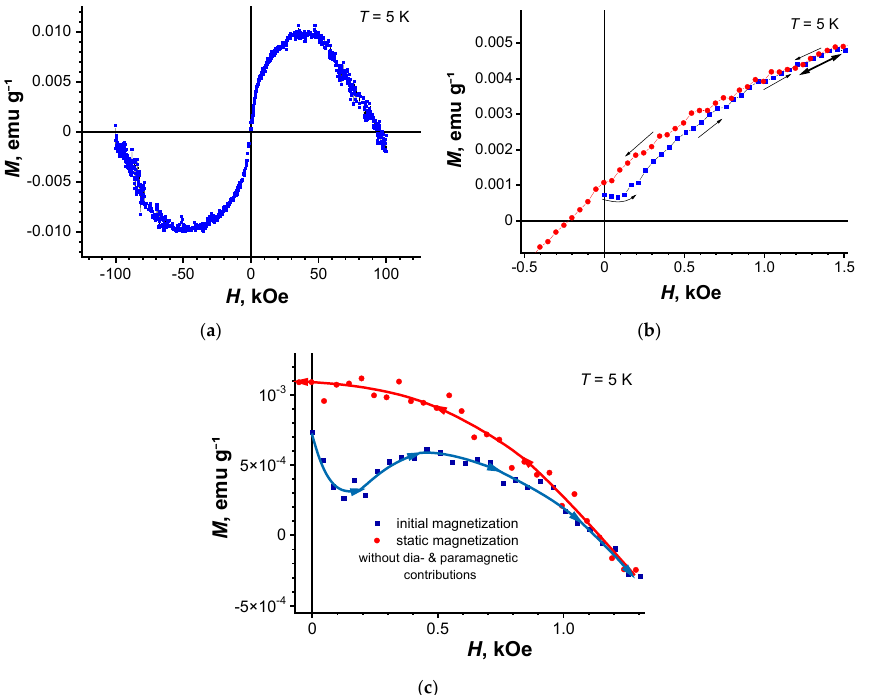
Figure 10. Dependence of the magnetic moment for composite 2 on the strong ( a ) and weak magnetic fields ( b ). Magnetization loop after subtracting the diamagnetic and paramagnetic contributions ( c ). T = 5 K. Black points mark the initial magnetization curve.